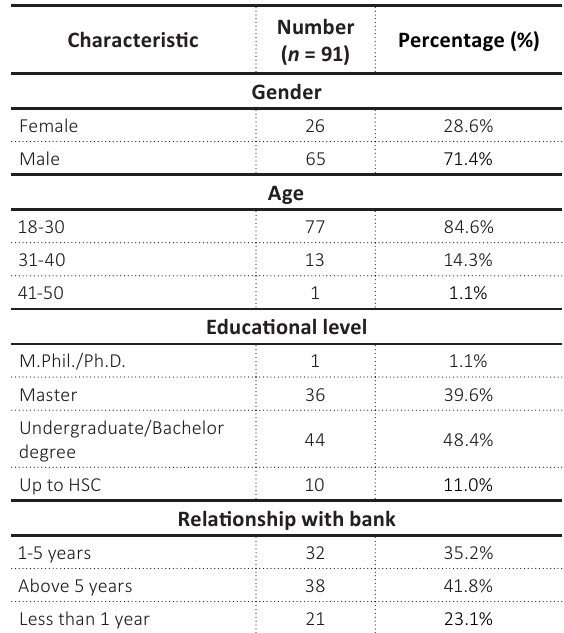
Table 3. Sample characteristics